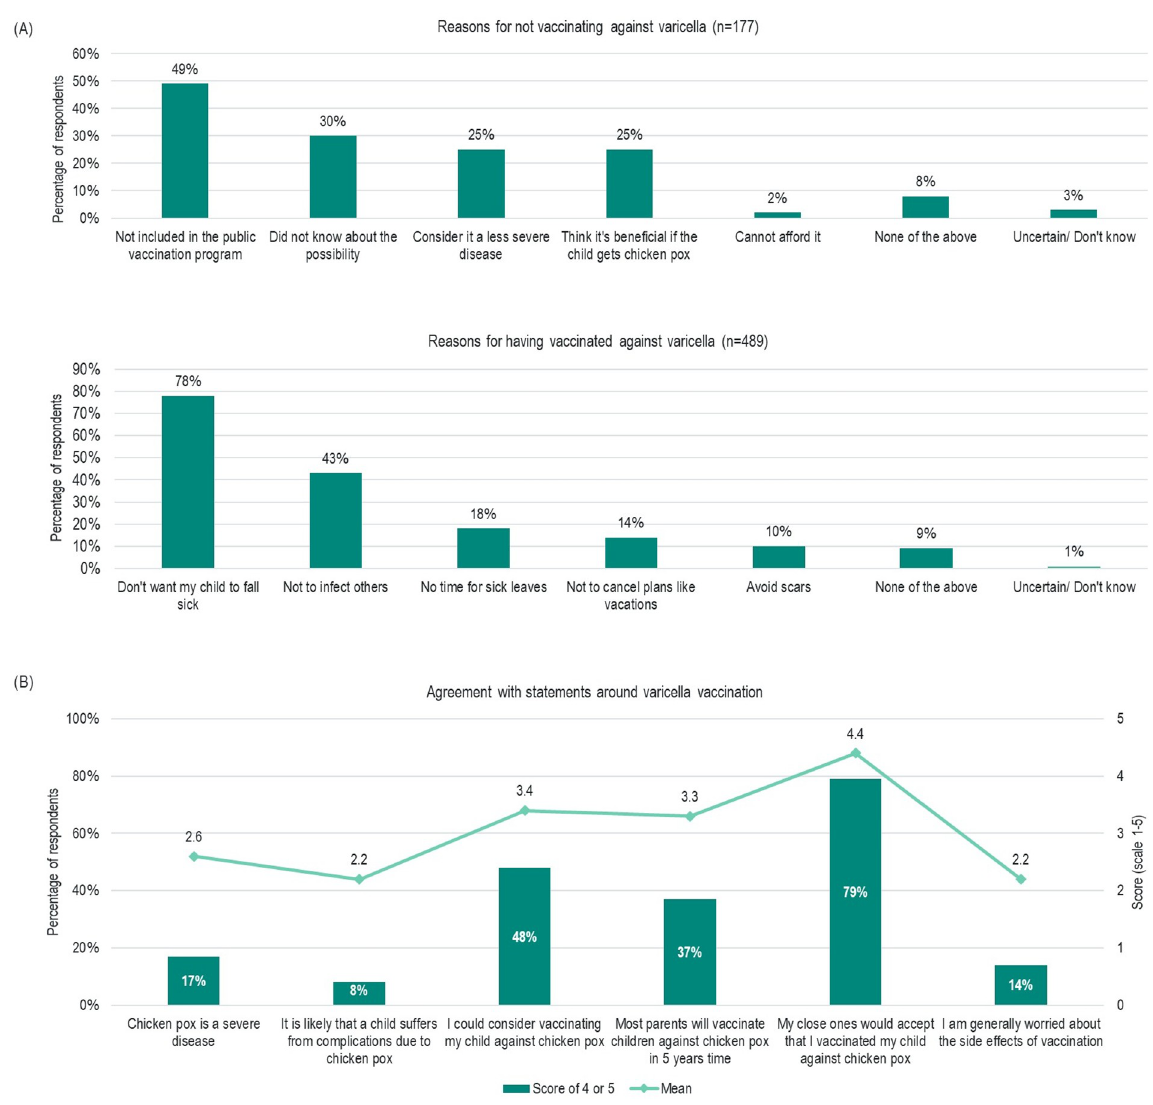
Fig 2. Perceptions of varicella vaccination. (A) Bar charts showing reasons for parents not vaccinating child against varicella infection (n = 177) and reasons for having vaccinated against varicella infection (n = 489); (B) Graph showing respondent agreement with statements around varicella vaccination, from total study sample (n = 2212). Respondents were asked to rate how strongly they agree or disagree with each statement on a scale of 1 to 5, where 5 is strongly agree. Mean scores and the percentage of respondents rating each statement as 4 or 5 are